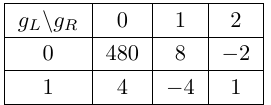
for the homology class β = ( d β